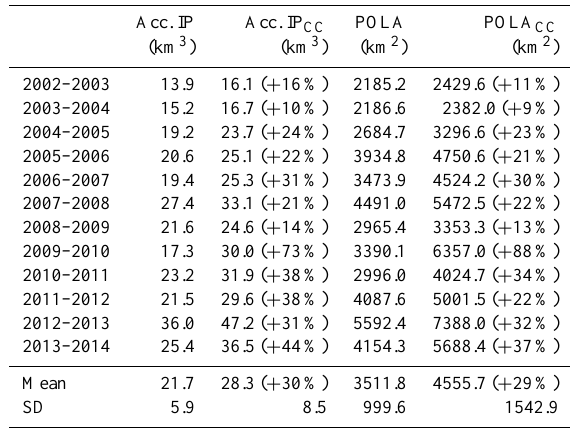
Table 2. Accumulated ice production (IP) in cubic kilometers per winter and average polynya area (POLA) in square kilometers for each winter season (November to March) in the Storfjorden polynya, together with the interannual average (mean) and its stan- dard deviation (SD). CC denotes values after coverage correction, with relative increase compared to uncorrected values in brack- ets. All values are calculated within the predefined polynya mask (Fig.